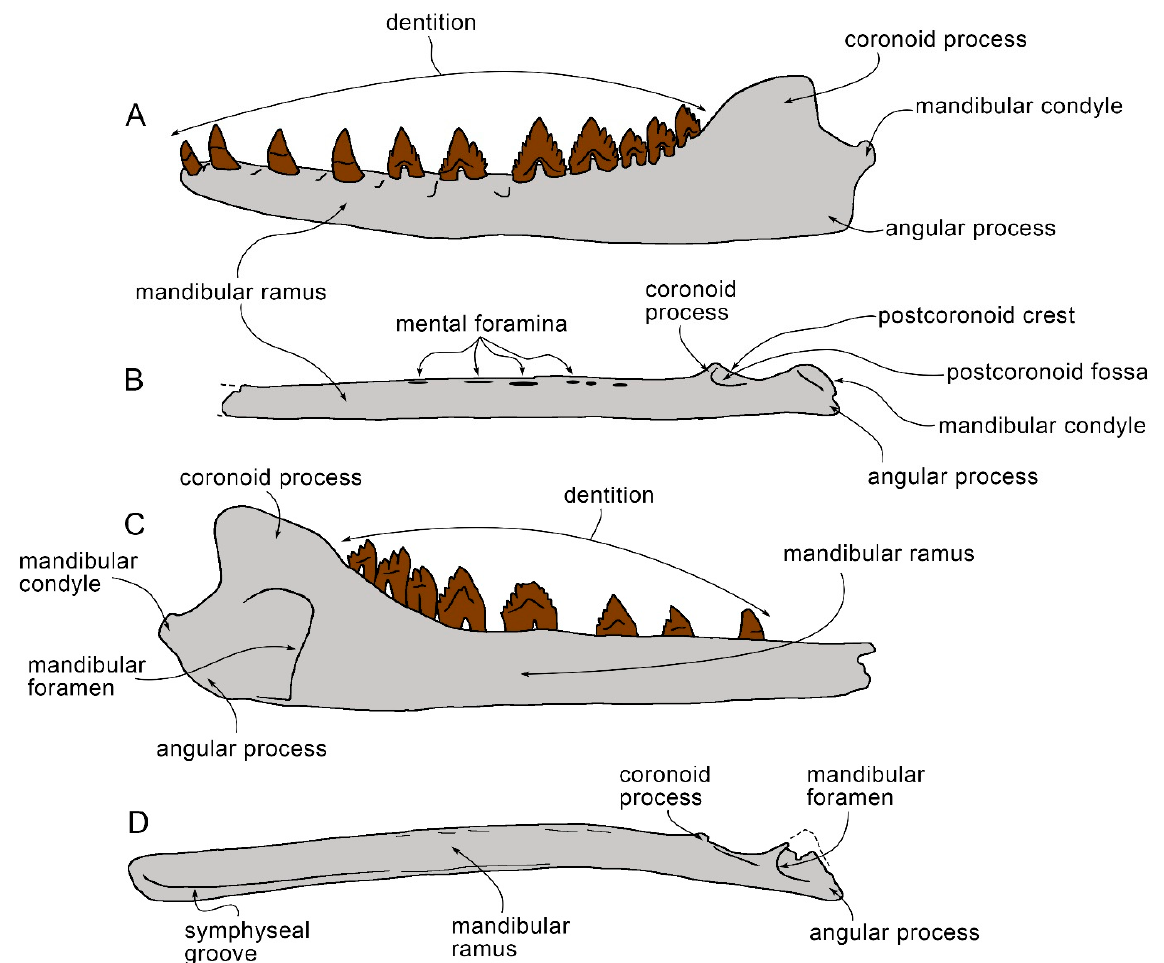
Figure 3. Schematic representation of the dentary of an archaeocete and a mysticete showing characters discussed in the text. ( A ) Dorudon atrox , dentary in lateral view. ( B ) Herpetocetus morrowi , dentary in lateral view. ( C ) Dorudon atrox , dentary in medial view. ( D ) Herpetocetus morrowi , dentary in medial view. Not to scale. The dentaries are represented as if they shared the same anteroposterior length. Representations of mysticete dentaries follows the conventional rules described in [17].